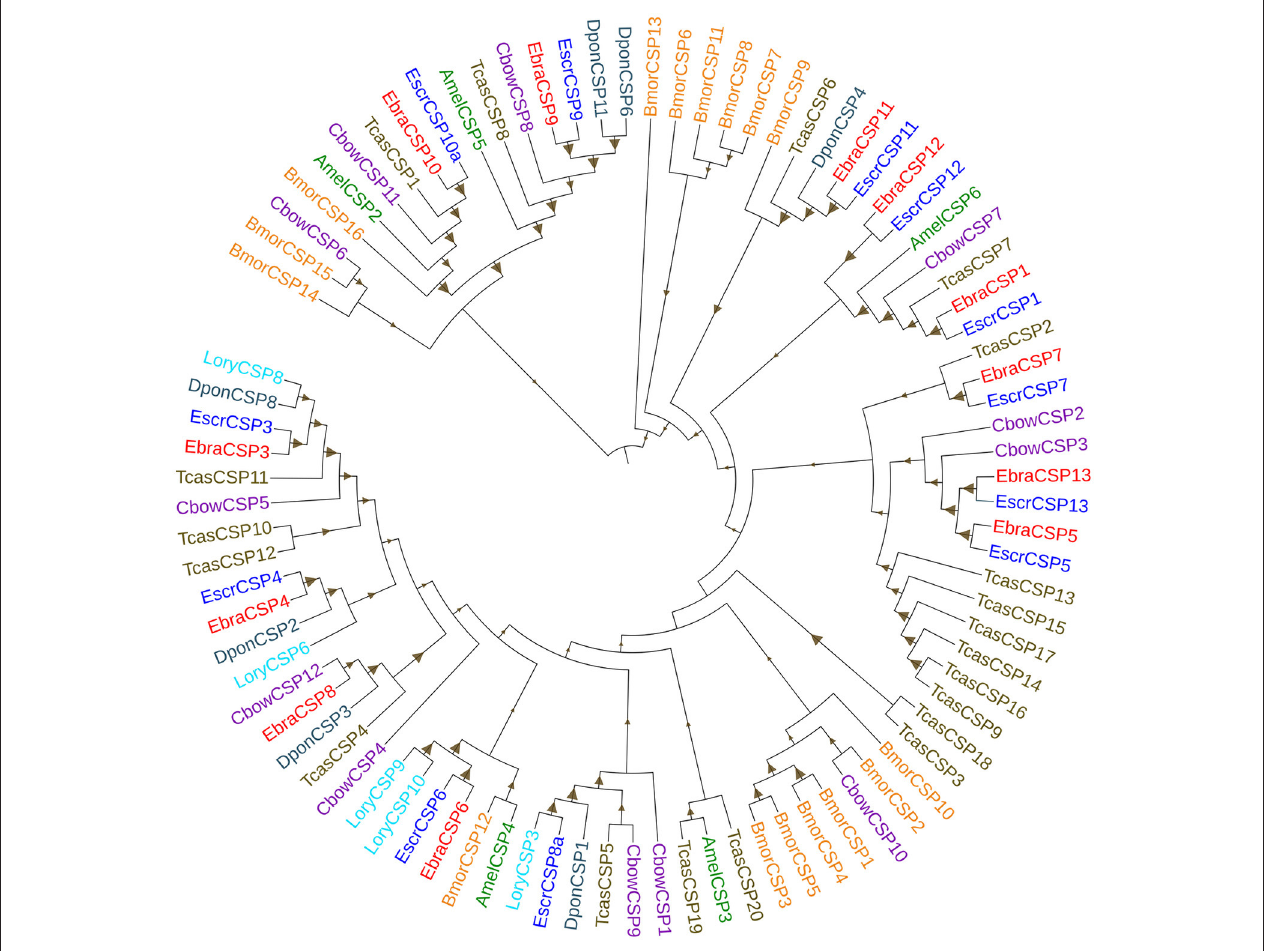
FIGURE 1 | Phylogenetic tree of chemosensory proteins (CSPs). EbraCSPs, CSPs of Eucryptorrhynchus brandti ; EscrCSPs, CSPs of Eucryptorrhynchus scrobiculatus ; BmorCSPs, CSPs of Bombyx mori ; AmelCSPs, CSPs of Apis mellifera ; TcasCSPs, CSPs of Tribolium castaneum ; DponCSPs, CSPs of Dendroctonus ponderosae ; CbowCSPs, CSPs of Colaphellus bowringi ; LoryCSPs, CSPs of Lissorhoptrus oryzophilus